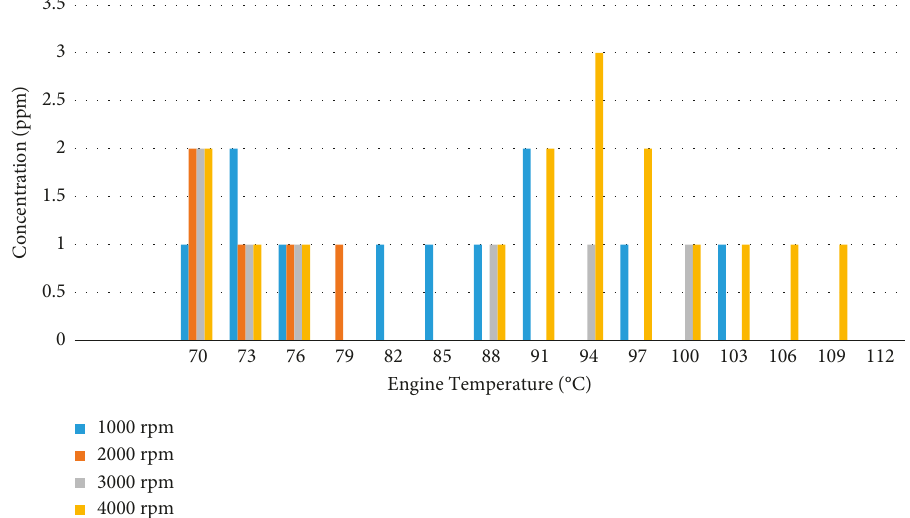
Figure 6: H 2 S exposure at 1m distance for different engine speeds for gasoline +H 2 blend.